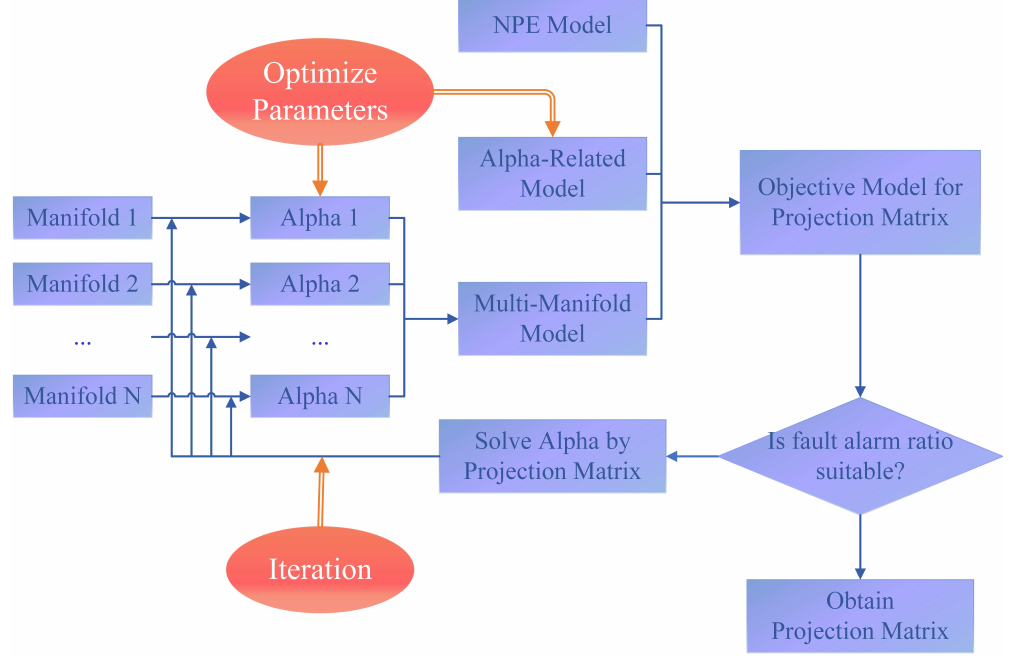
Figure 3. Iterable structure for